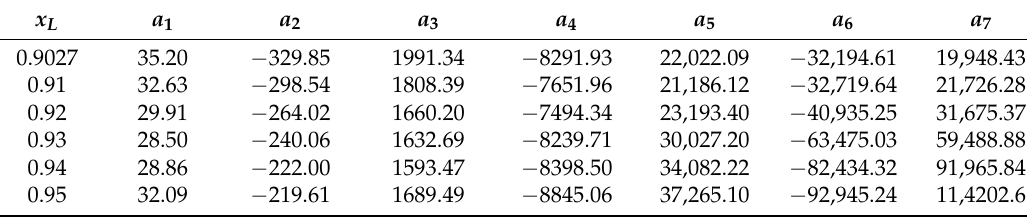
Table 3. Coefficients in the polynomial fitting function of restoring